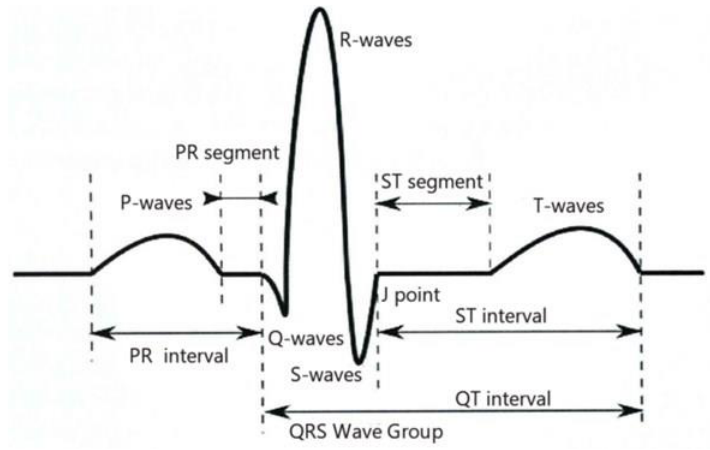
Figure 1. Schematic diagram of heartbeat.